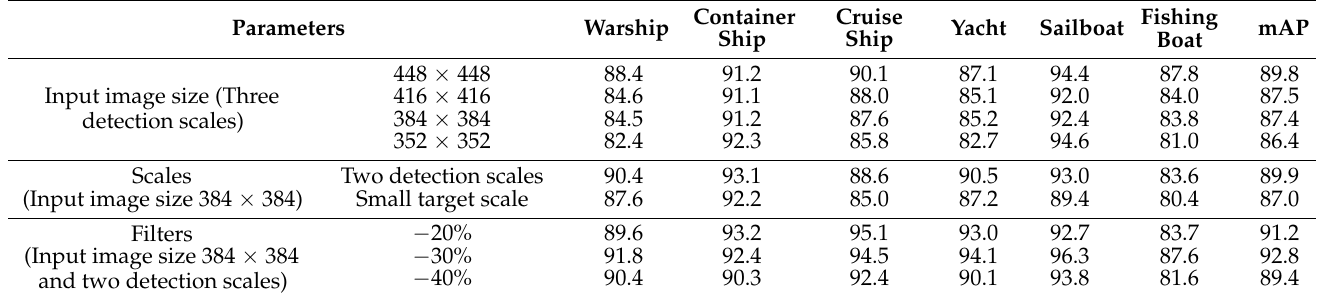
Table 3. Detection accuracy of Yolov3 on test data under different simulation